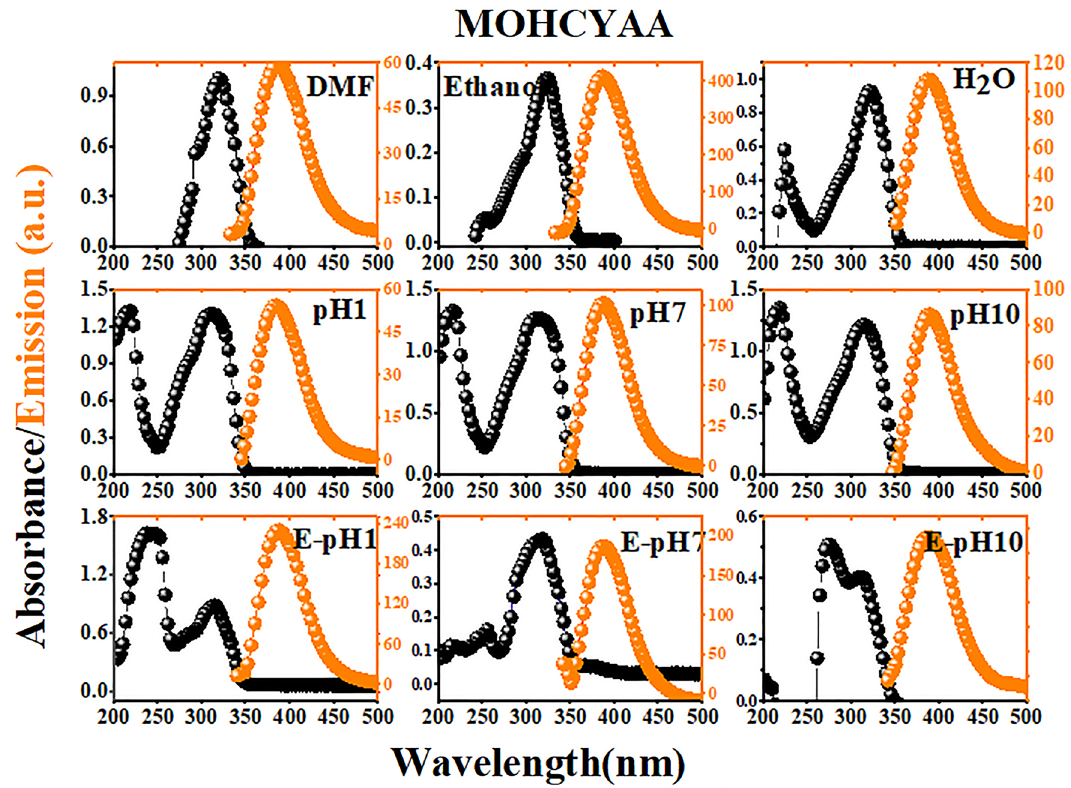
Figure 4. Normalized absorption and fluorescence spectra of MOHCYAA in different solvents.